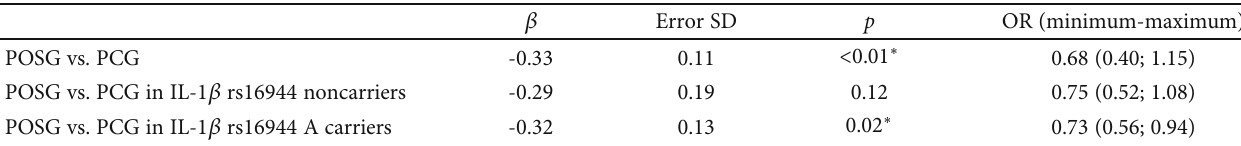
Table 6: Association of IL-1 β and POSG treatment with HAM-A